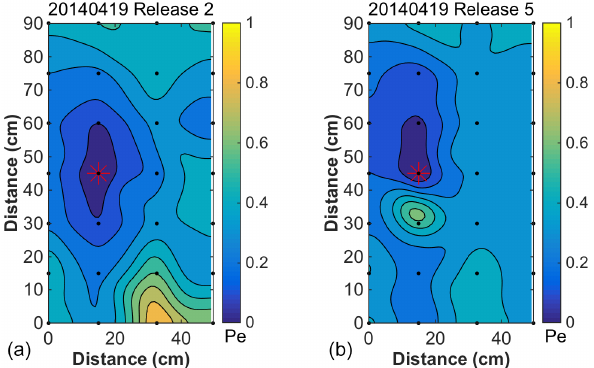
Figure 10. Normalized Péclet number for windy case 8 (a) and low- wind case 11 (b) . Both cases were obtained during the same picket deployment. Case 8 shows preferential streamwise dispersion (see also windroses in Fig. 7) as well as enhanced dispersion along high permeability pathways. In panel (b) , but for the anomalously large Péclet number gradient just below the release point (due to the re- lease volume), the gradient is weak relative to panel (a) , character- istic of a diffusion-dominated